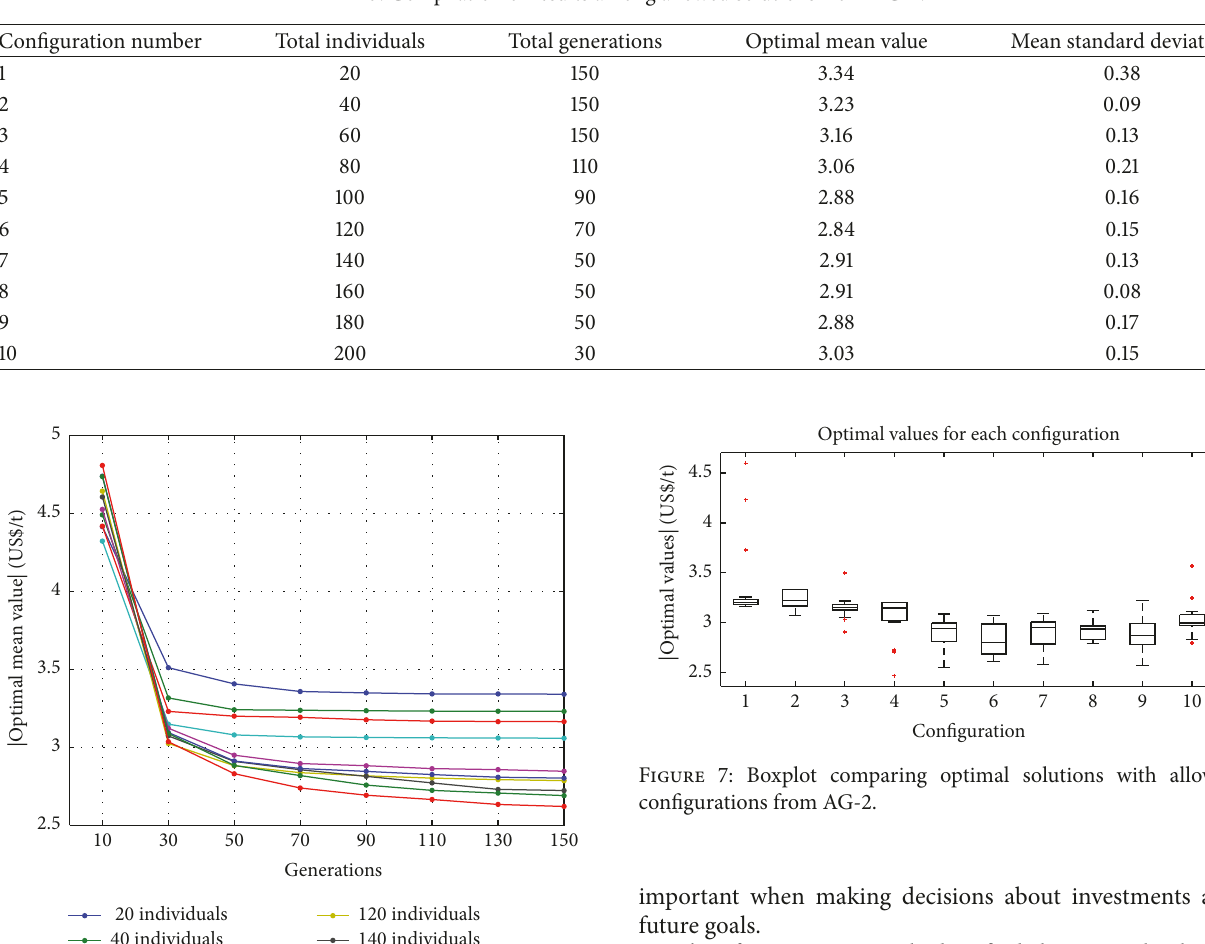
Table 3: Compilation of results among allowed solutions from AG-2.